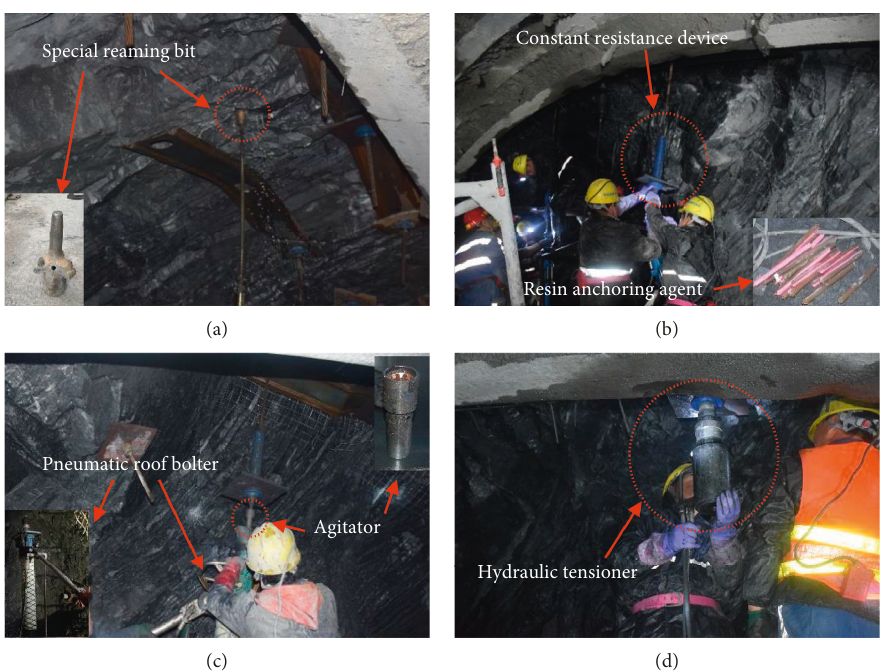
Figure 9: NPR anchor cable installation process. (a) Reaming operation. (b) Installing constant resistance device. (c) Mixing resin an- choring agent. (d) Applying pretension force to the anchor cable.